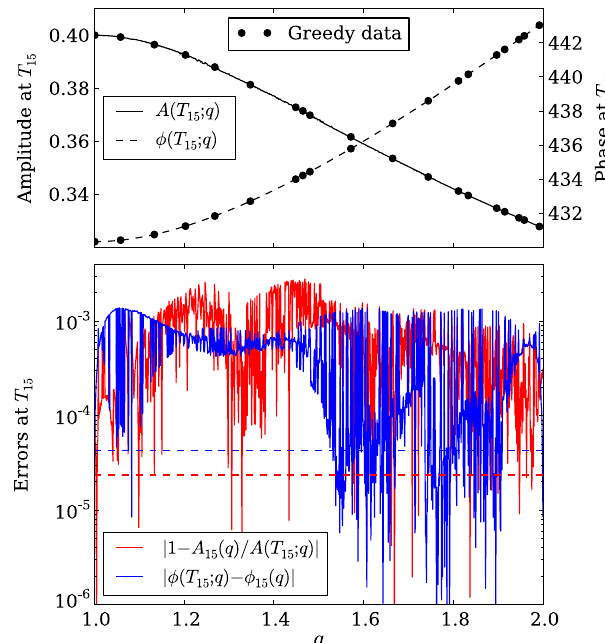
FIG. 7. Top panel: Amplitude (solid line) and phase (dashed line) of the fiducial EOB training space waveform at the 15th selected empirical time as a function of q along with the greedy data (circles). The empirical time is T 15 ¼ 28 . 5 M after merger and corresponds to the largest pointwise relative error for the least squares fit to the amplitude as quantified by Eq. (26). Bottom panel: The pointwise least squares errors for the amplitude (red) and phase (blue) at T 15 evaluated for 1,000 randomly selected waveforms. The dashed lines correspond to the maximum pointwise error for the second empirical node T 2 ¼ − 2 ; 367 M , which has the smallest maximum error of all the nodes.